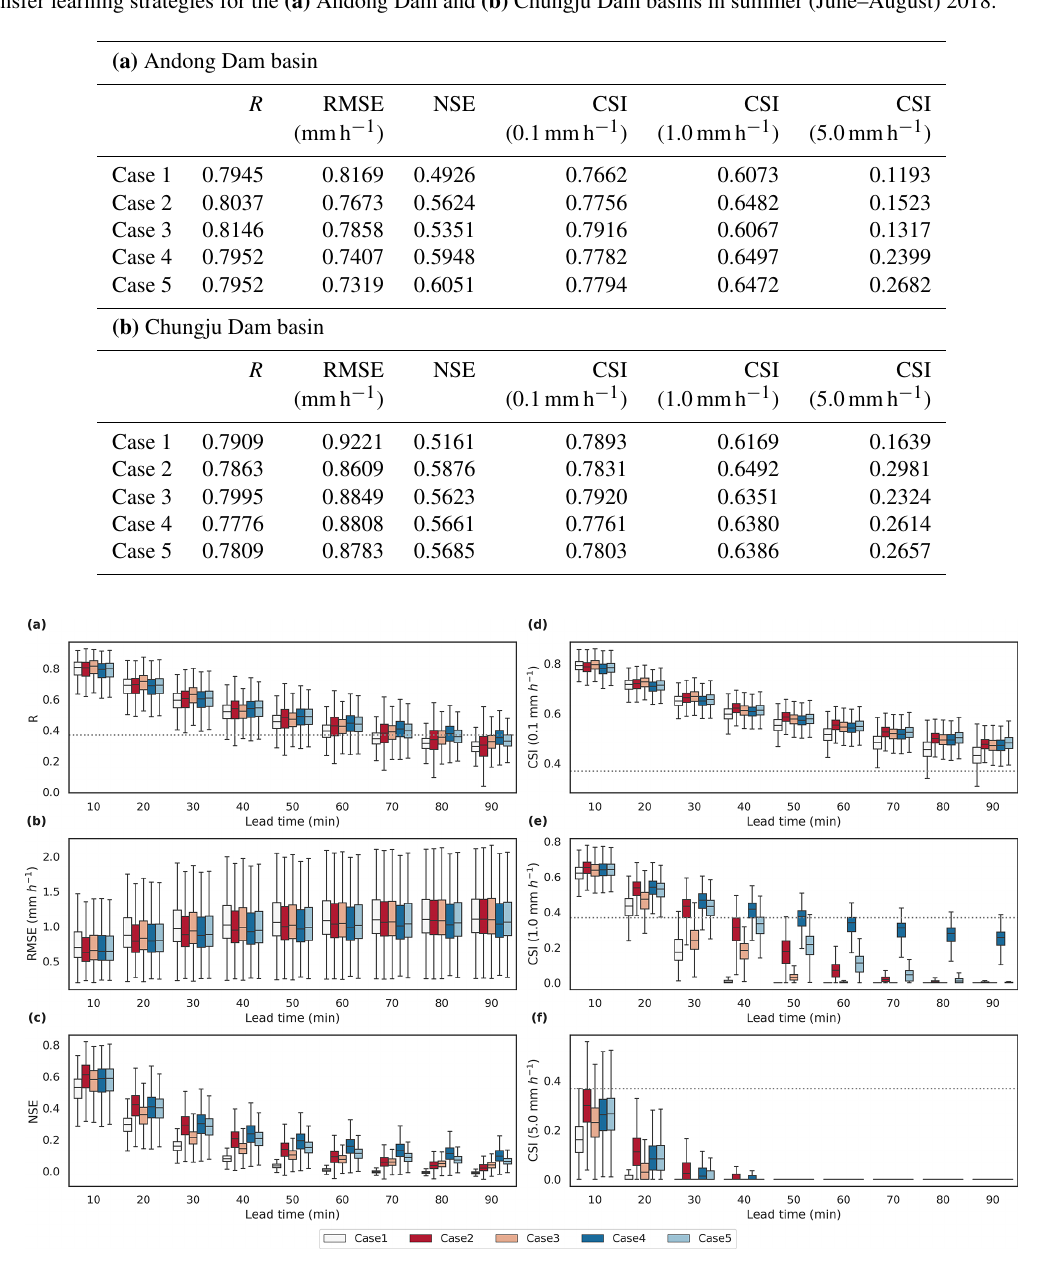
Figure 9. Box plots of the verification metrics of model predictions at the lead time up to 90min over all grid cells from the Chungju Dam basin. Panels (a) – (c) represent R , RMSE, and NSE, and (d) – (f) represent CSI at intensity thresholds of 0.1, 1.0, and 5.0mmh − 1 respectively. Dotted gray line represents the predictability threshold (1 /e